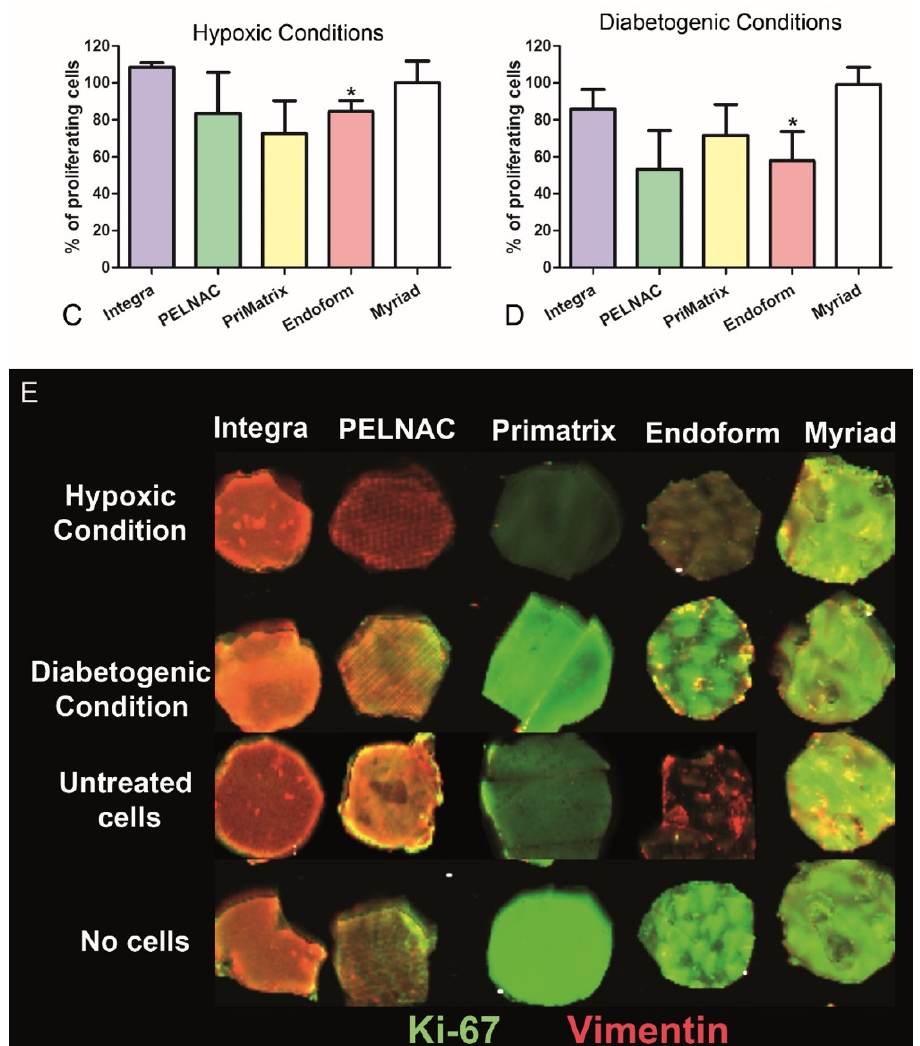
Figure 3. ( A ) After 36 h of culture onto the different dermal substitutes, ADMECs were stained with the fluorescent dye FAST Dil; labelled cells were lysed to release the dye in solution, and the fluorescence was read at 353 nm with Infinite200 TECAN reader. Results are expressed as a ratio between the fluorescence of the cells seeded in the scaffold and the fluorescence of the total number of cells (the calculation formula is reported in the Supplementary Material). Data from five independent experiments are presented as mean ± SE. * p < 0.05; ** p < 0.01 vs. Integra ® . ( B – E ) The cell-colonized scaffolds under resting conditions ( B ), under hypoxic conditions ( C ) or diabetogenic conditions ( D ) were fixed and stained with mouse antihuman vimentin and rabbit antihuman Ki67 antibodies and analyzed by the fluorescent scanner Odyssey CL-x (LI-COR Biosciences, Lincoln, NE, USA). ( E ) A representative image of labelled scaffolds was acquired by using LI-COR Odyssey imaging system, and data were processed using Image Studio system 5.0 software (LI-COR Biosciences, Lincoln, NE, USA). The formula used for the calculation is reported in the Supplementary Ma- terial section. Data from four independent experiments conducted in triplicate are presented as mean ± SE. * p < 0.01 vs. Integra; n.s. = not